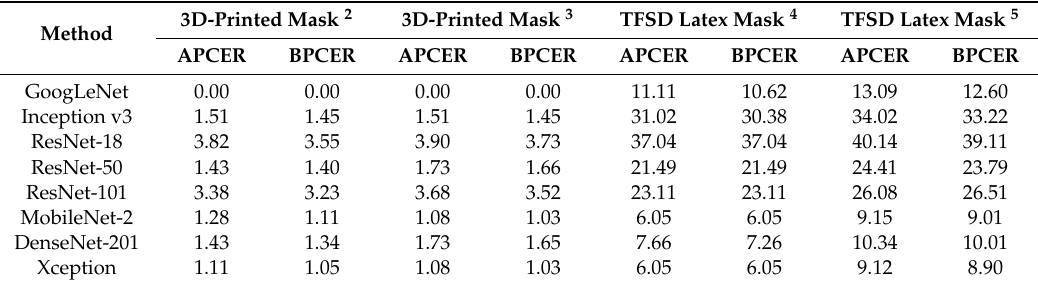
Table 8. Results of cross-material validation 1